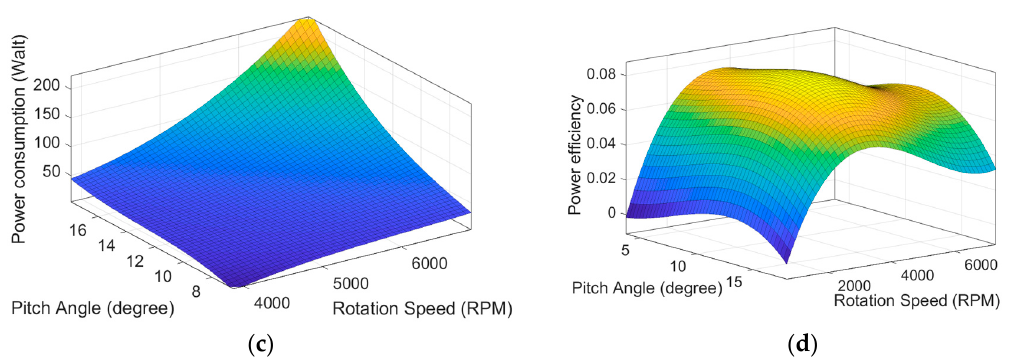
Figure 4. The experimental data of the VPP system, showing the response surfaces of the ( a ) thrust, ( b ) moment of force, ( c ) power consumption, and ( d ) thrust per unit watt to the pitch angle and rotational speed of the propeller.